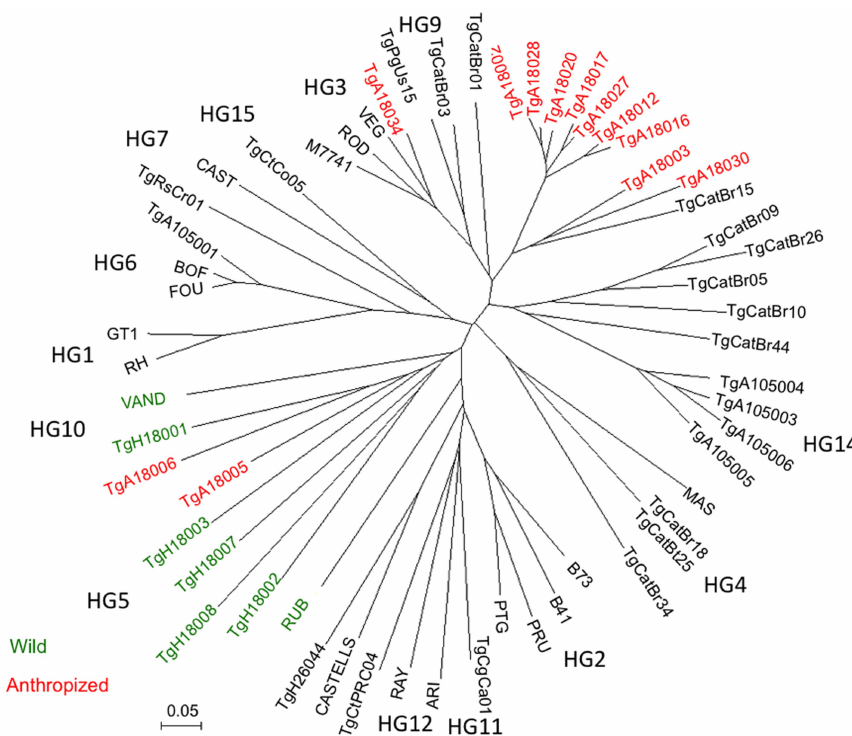
Figure 2. Analysis of T.gondii strains based on microsatellite markers. Strains isolated from anthropized environment (red) vs. wild Neotropical rainforest of French Guiana were compared to type strains representing the major haplogroups (HG). Neighbor-joining analysis of 15 microsatellite markers, displayed as an unrooted tree drawn using MEGA. Anthropized strains grouped with HG3 and HG9, while wild strains were deep branching and associated with a variety of divergent HGs. Color-coding indicates the region of origin: anthropized environment (red), wild Neotropical rainforest (green), HG reference strains (black).